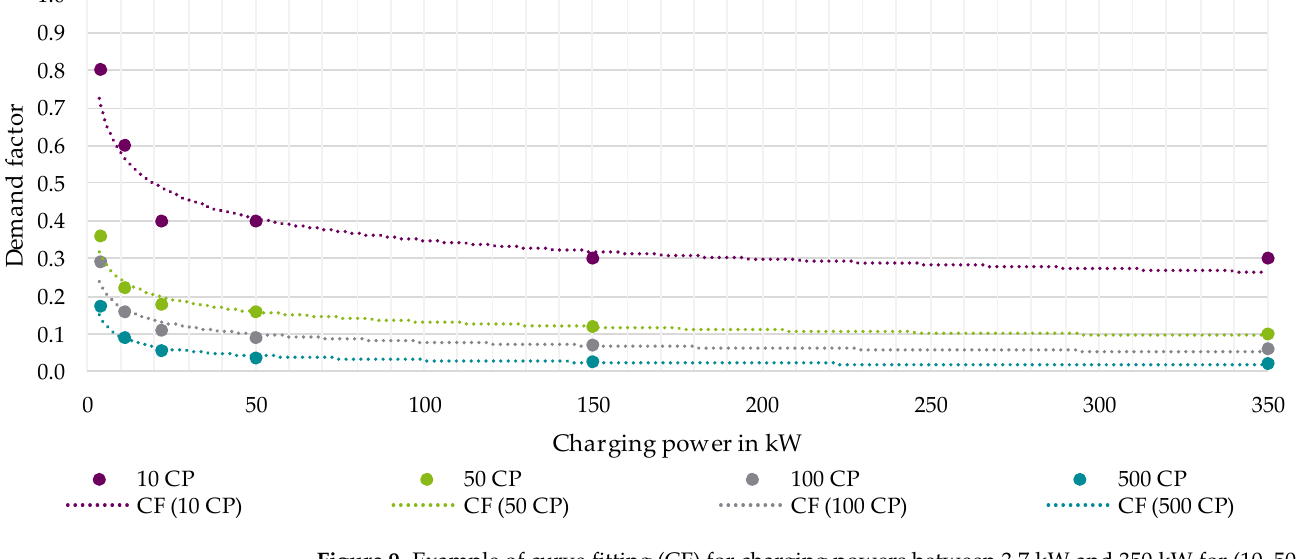
Figure 9. Example of curve fitting (CF) for charging powers between 3.7 kW and 350 kW for (10, 50, 100 and 500) charging points (CP).